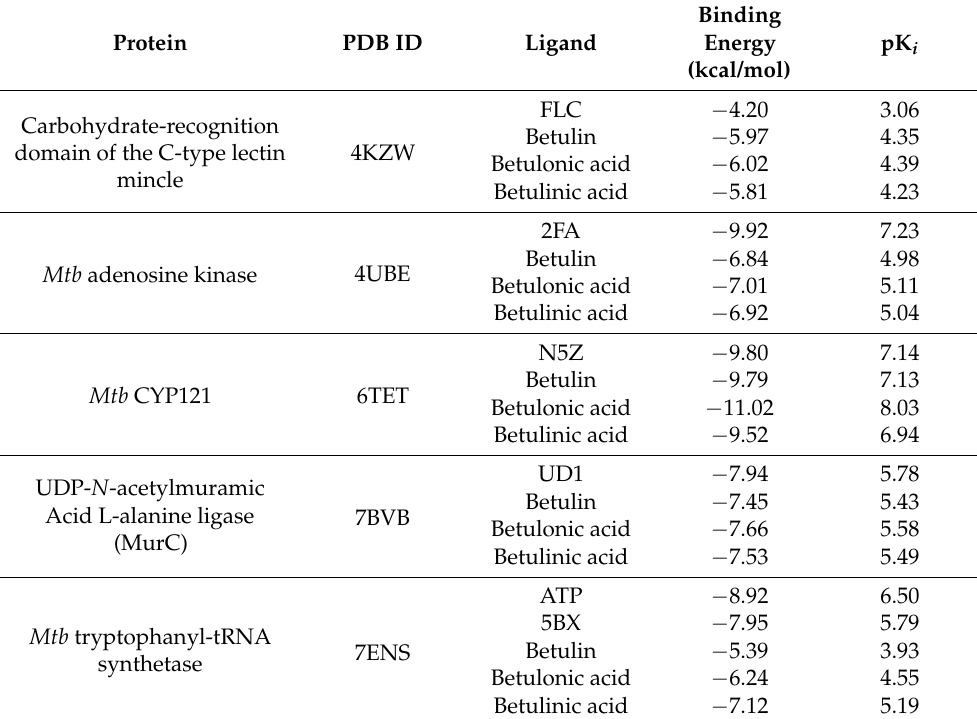
Table 2. Molecular docking results for complexes of listed proteins with their initial ligands 1 , betulin, betulonic, and betulinic